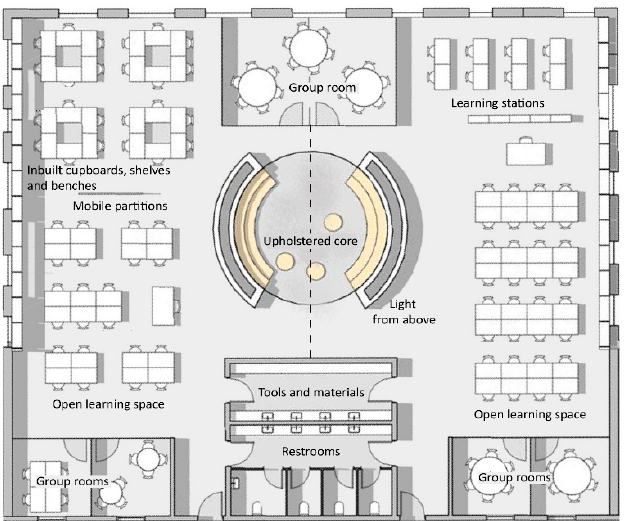
Figure 5. A draft illustration of a classroom or tvennd by ARKÍS architects [30].